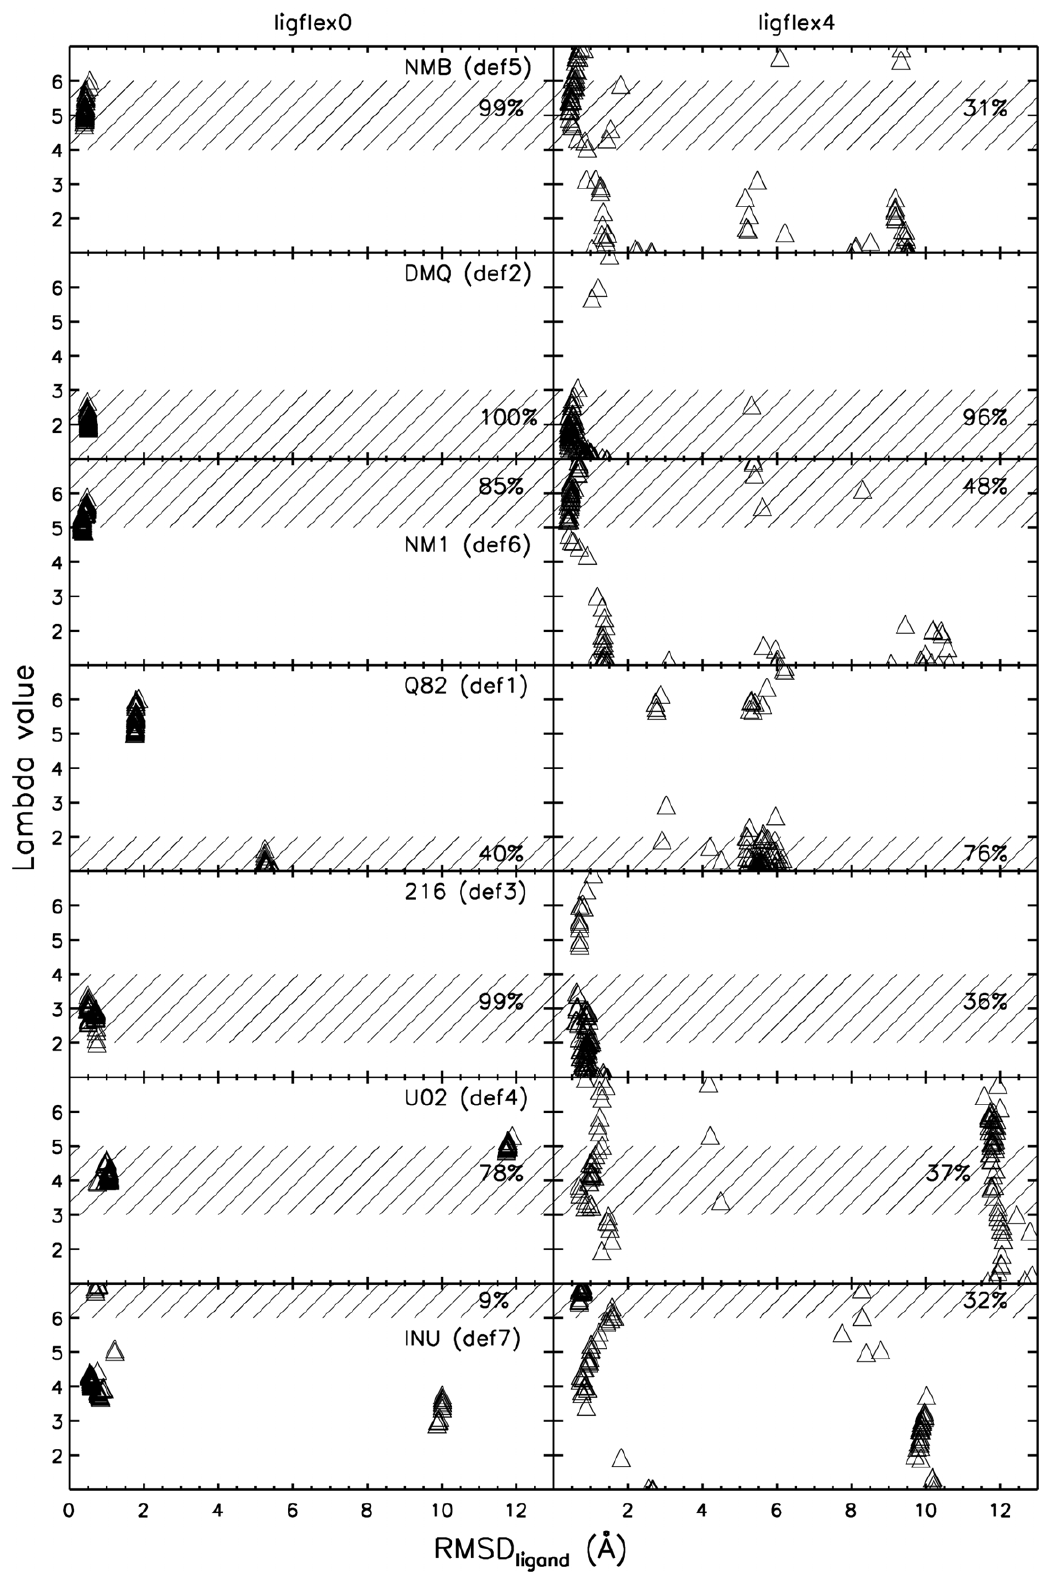
Figure 5. Ligand placement quality vs. docked receptor structure. HIV-1 protease structure vs. RMSD ligand for flexible receptor docking applied to the true binder test set. Variation of the parameter lambda corresponds to a continuous deformation of the HIV-1 protease receptor structure beginning at the bound form pdb ID 1HVH (lambda=1) and following the order 1DMP, 1HWR, 2UPJ, 1AJV, 1G2K and ending with 7UPJ